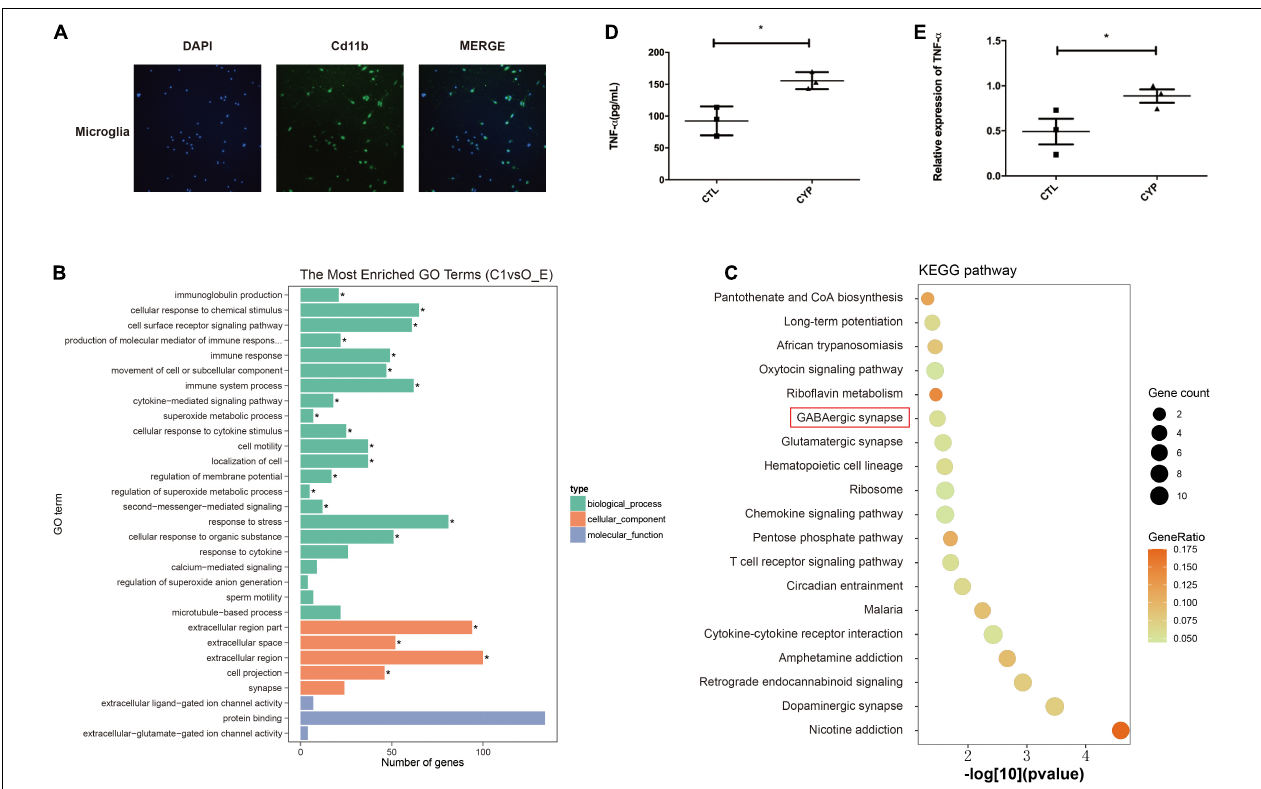
FIGURE 3 | Primary microglial transcriptome and primary culture indicates immune activation in offspring from CYP11A1 -overexpressing dams. (A) Microglial cells from the offspring of AD-CYP11A1-treated pregnant rats were identified by their Cd11b positivity. (B) GO analysis revealed the activation of immune responses in primary microglia from the CYP11A1 overexpression group. (C) KEGG analysis indicated that GABAergic synapse related genes were enriched from the CYP11A1 overexpression group (over_represented p = 0.033). N = 3 for each group, and only male rats were used for the transcriptomic analysis. (D,E) Expression of the inflammatory tumor necrosis factor-alpha (TNF- α ) was increased in the primary microglia in the CYP11A1 adenovirus infected cells. ELISA revealed TNF- α in the adenovirus infected culture medium (D) , and real-time PCR detected TNF- α mRNA in the microglia (E) (* P <